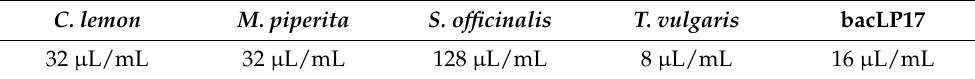
Table 1. MICs of EOs and bacLP17 used alone against Listeria monocytogenes NCTC 10888.